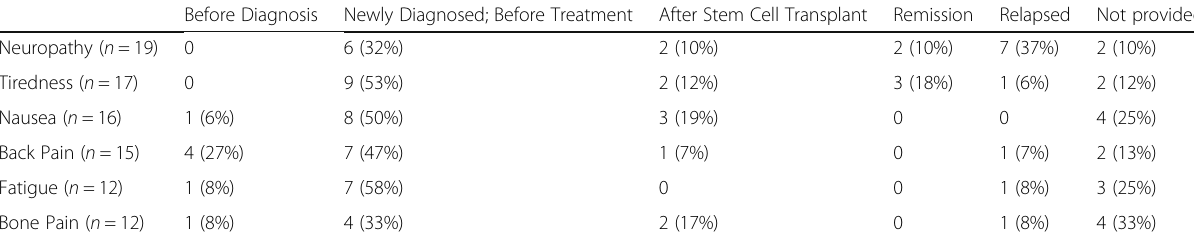
Table 2 Symptom Discussed by Stage of Disease Journey Before Diagnosis Newly Diagnosed; Before Treatment After Stem Cell Transplant